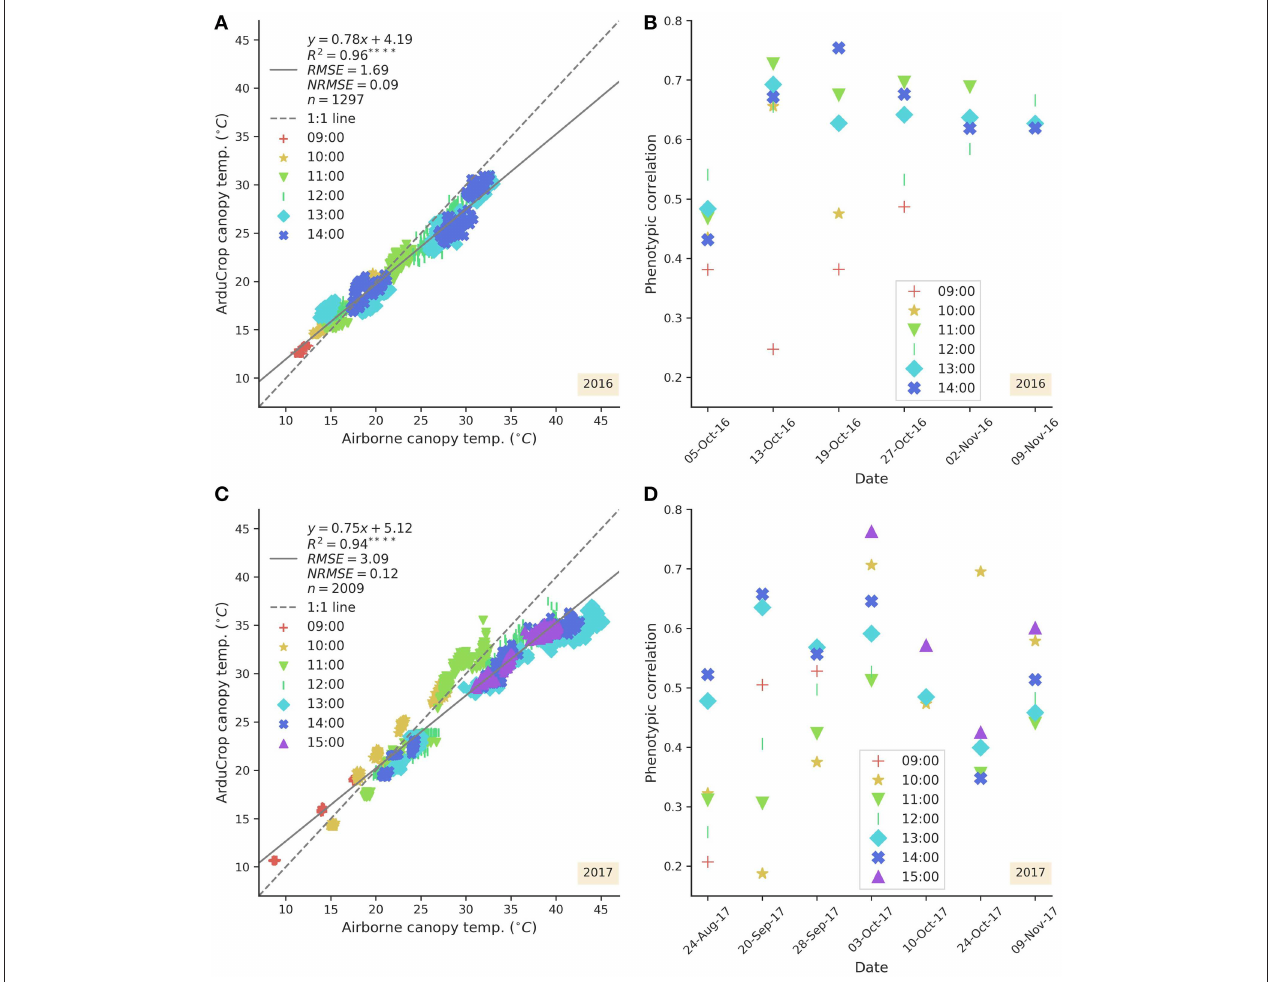
FIGURE 9 | Association across all dates between airborne canopy temperature (CT) and ArduCrop CT (where for a given airborne CT event, data was compared to the nearest hourly ArduCrop CT event). Scatter plots for 2016 (A) and 2017 (C) . Scatter plots of phenotypic correlations between airborne CT and ArduCrop CT for each date 2016 (B) and 2017 (D) . Data are coded by hour-of-day as per respective legend. CT data are best linear unbiased predictors of genotype effects